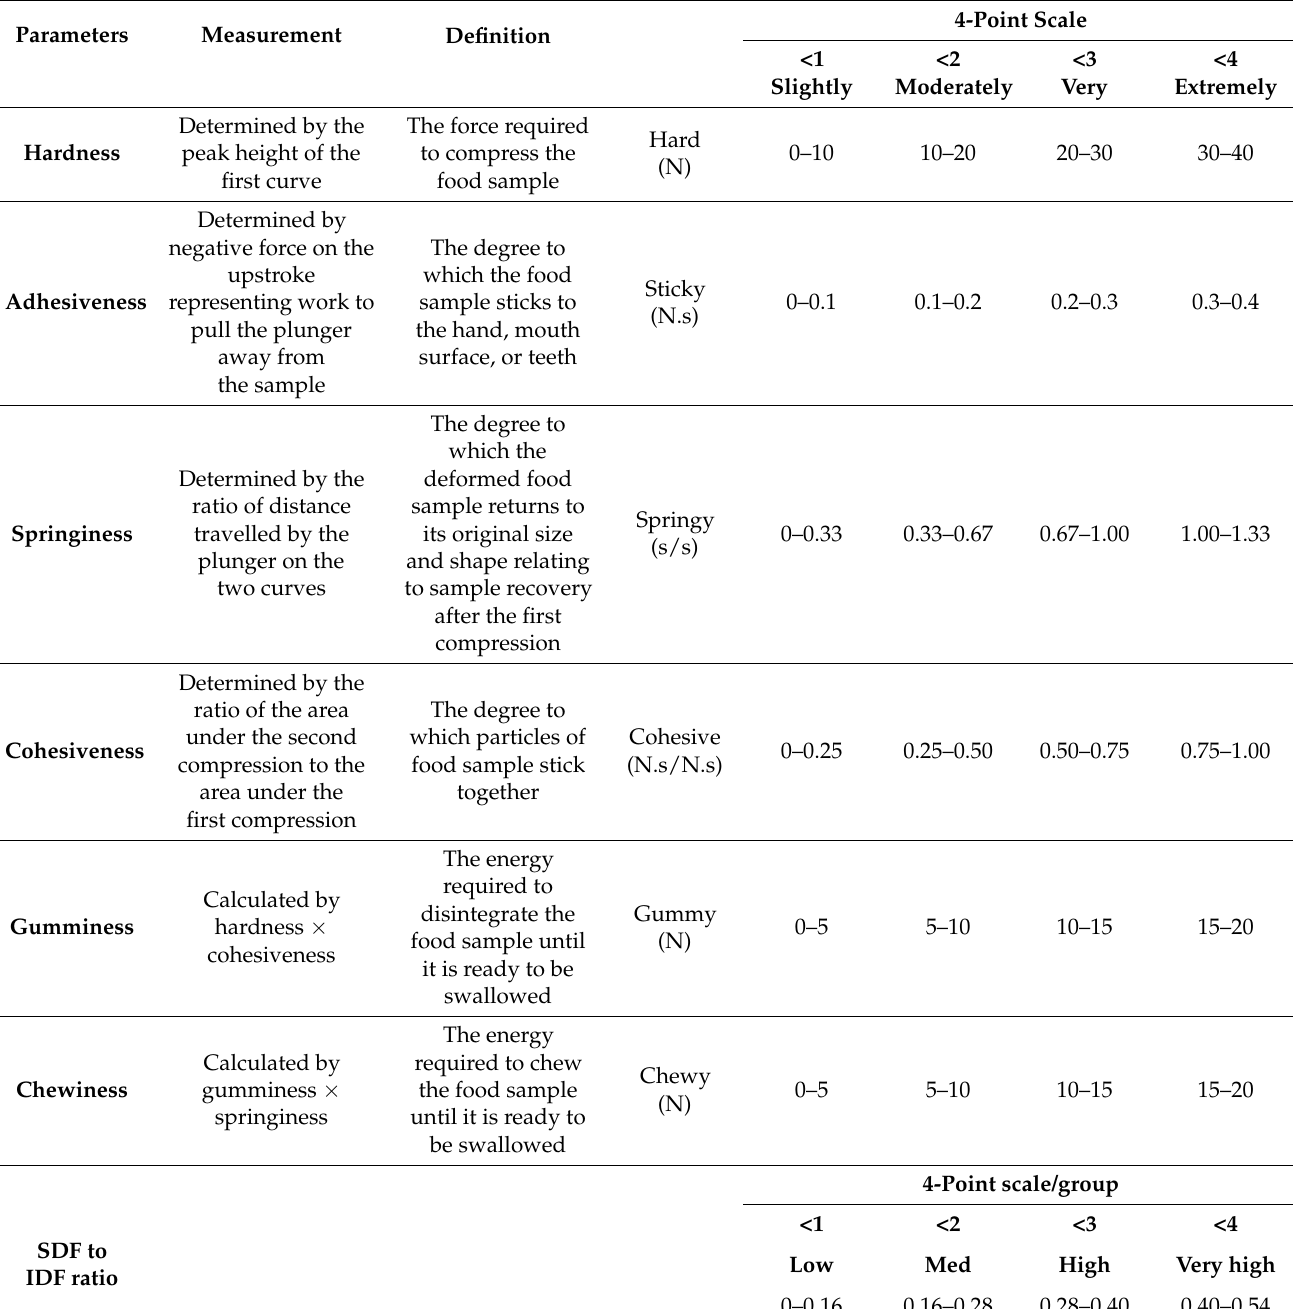
Table 1. 4-Point rating scale of texture parameters and the ratio of SDF and